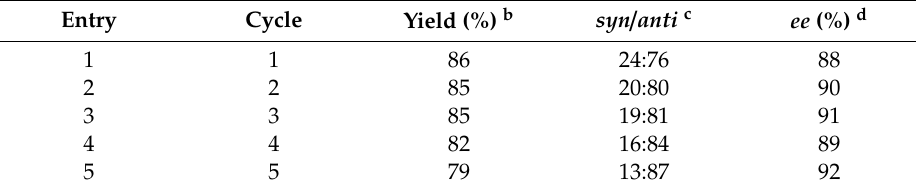
Table 5. Recycling P3 in the aldol reaction of cyclohexanone with 4-nitrobenzaldehye a